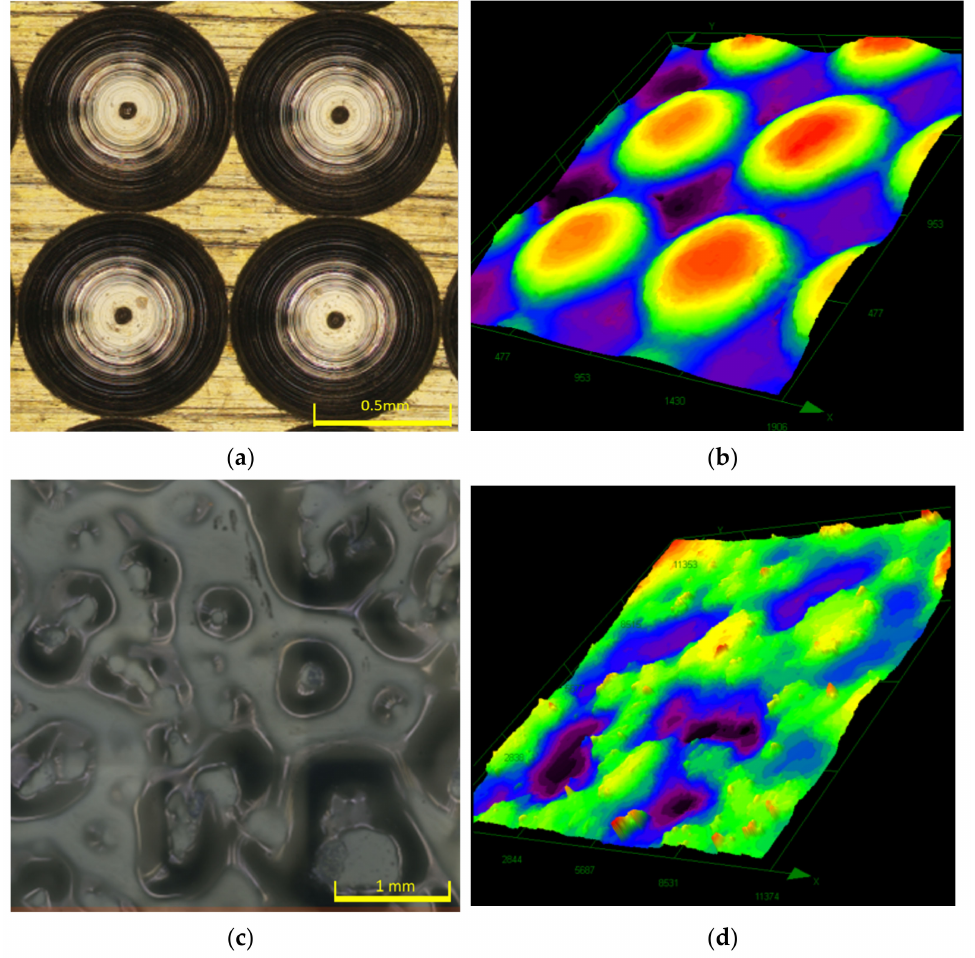
Figure 7. Small-scale ice roughness samples and copper molds measured by Olympus DSX-1000 microscope: ( a ) copper mold with spherical holes; ( b ) the three-dimensional contours of the regular bead ice sample; ( c ) glass mold with irregular roughness profile; ( d ) the three-dimensional contours of the irregular surface ice